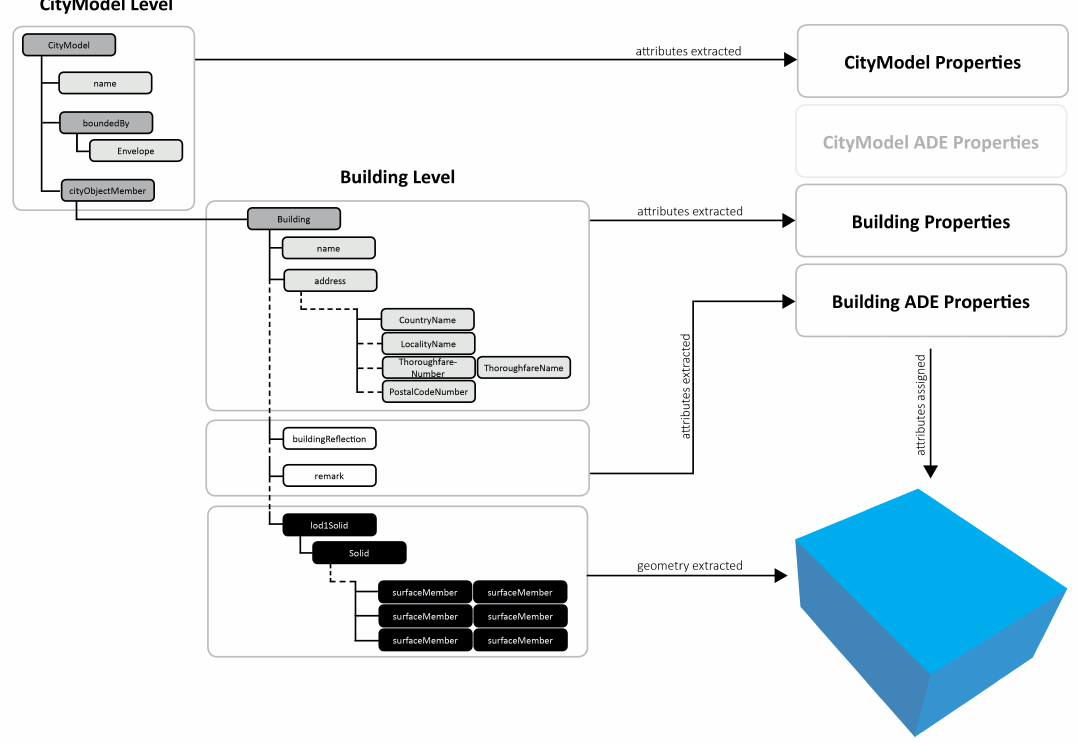
Figure 3. Rule application